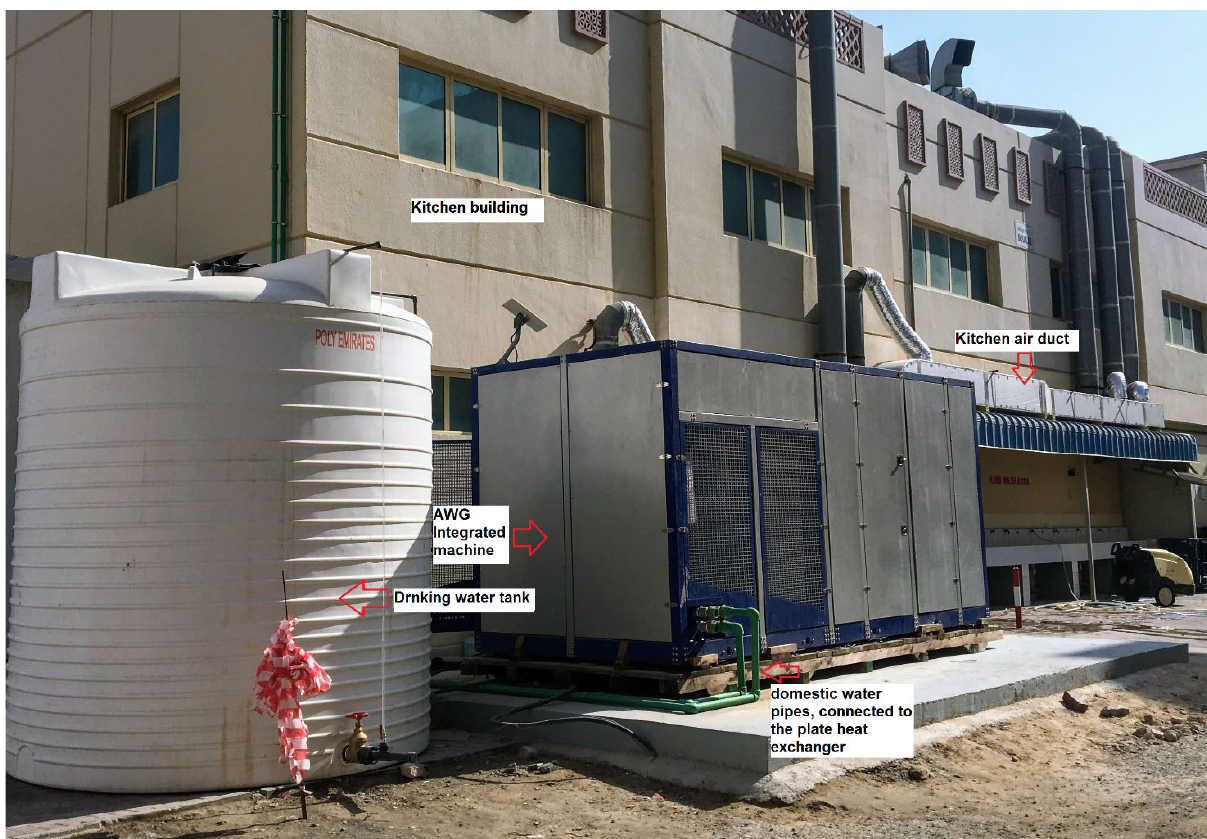
Figure 4. AWG integrated machine installation.